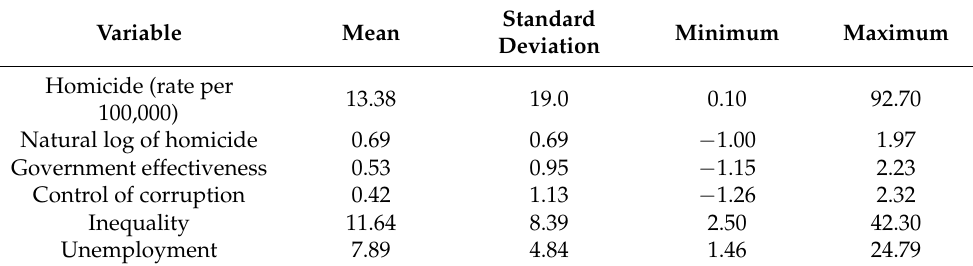
Table 1. Descriptive summary of each variable ( n = 39).